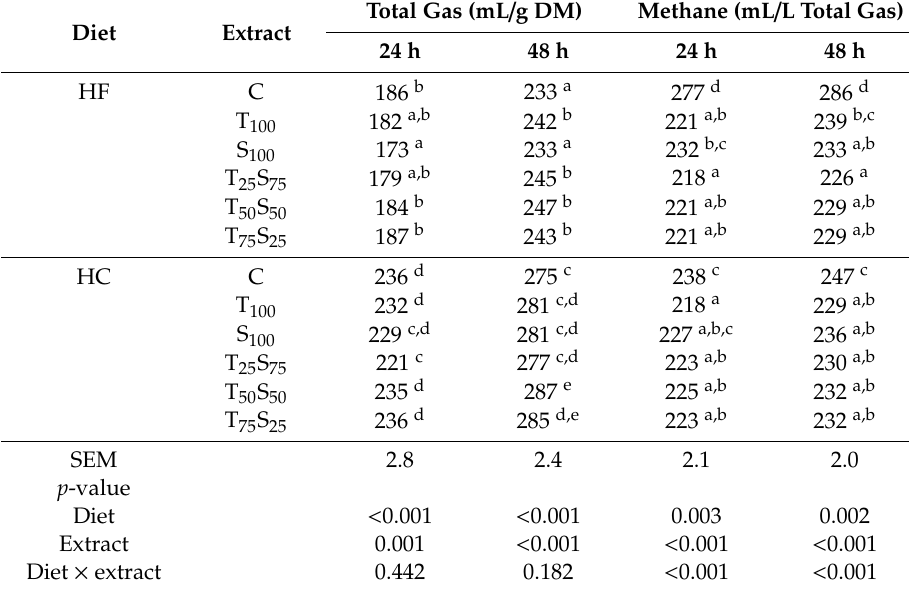
Table 2. In vitro gas production and methane proportion of total fermentation gas, as obtained with fermenting either the HF or the HC diets supplemented with varying proportions of plant extracts rich in tannins (T) and saponins (S).